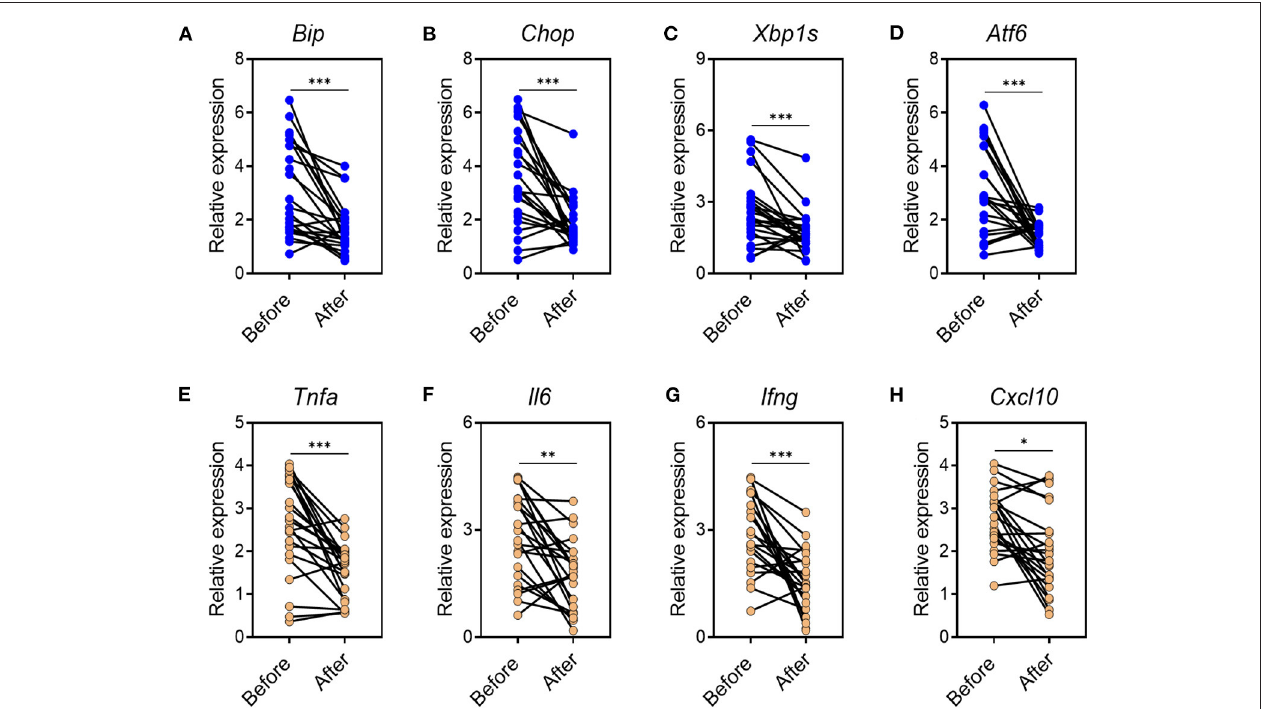
FIGURE 7 | CA reduces inflammatory responses and ER stress in mucosal tissues of UC patients. Inflamed mucosal tissues were obtained from patients with UC ( n = 23) as indicated and incubated overnight with or without CA (10 µ M). qRT-PCR was performed for gene expression. (A–D) ER stress signaling gene expression ( A , BIP; B , CHOP; C , XBP1s; D , ATF6) and (E–H) inflammatory agent expression ( E , TNF-a; F , IL-6; G , IFN-g; H , CXCL10) are shown. Data are presented as mean ± SD. Unpaired Student’s t test (two-tailed), * p < 0.05, ** p < 0.01, and *** p <